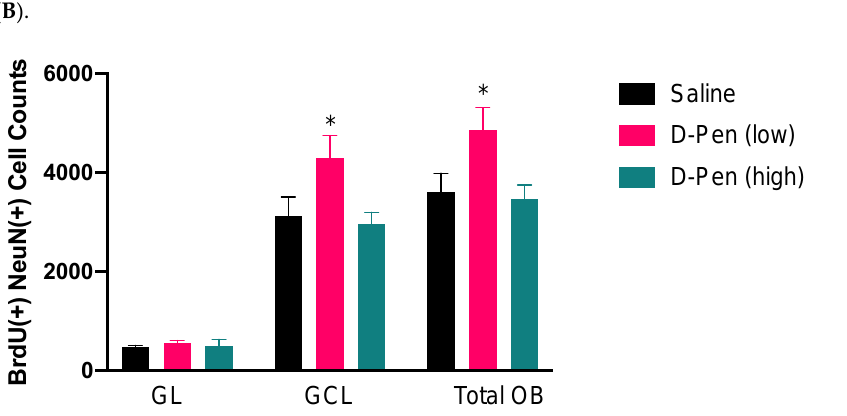
Figure 9. Adult neurogenesis in SVZ-RMS-OB axis following long-term ICV infusion of D-Pen. ( A ). Newly generated mature neurons in the OB’s GCL and GL labeled with NeuN and BrdU. Scale bar = 200 µm. The asterisk-marked area in GCL and pound-marked GL were further magnified and provided on the right, respectively. ( B ). Quantification of NeuN(+)/BrdU(+) newborn neurons in GCL and GL, and these two regions combined based on confocal 3D reconstruction. Data represent mean ± SD, n = 3/group. * p < 0.05, as compared with the controls.